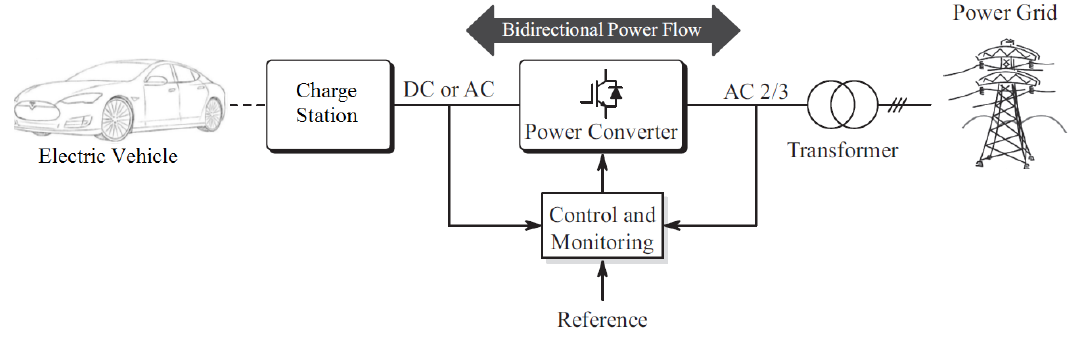
Figure 4. Block diagram of the V2G structure [22] .